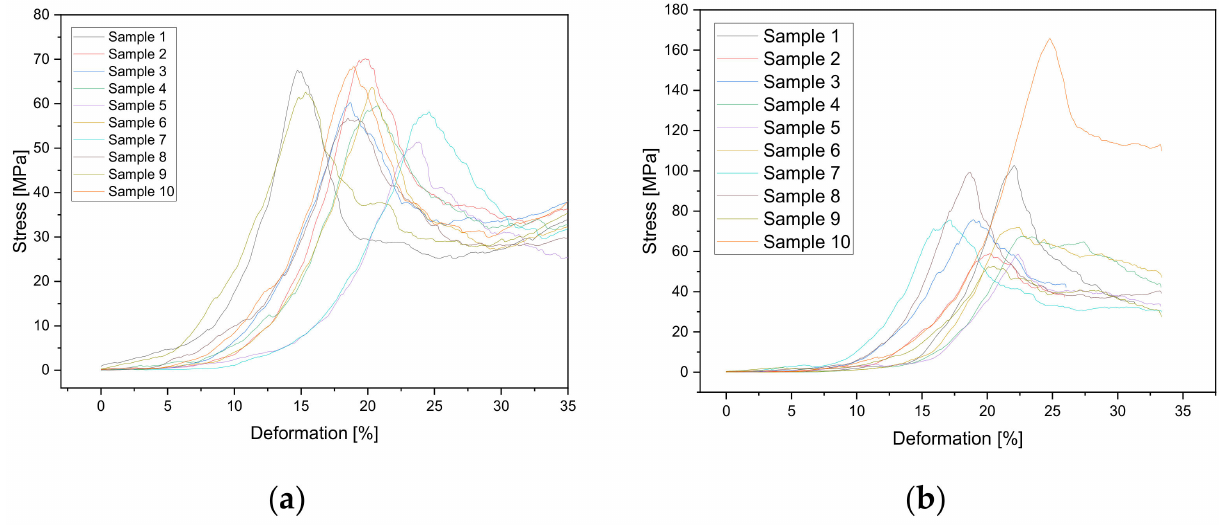
Figure 6. Stress–deformation curves for 3D-printed scaffolds with 250 µ m strand width ( n = 10) after